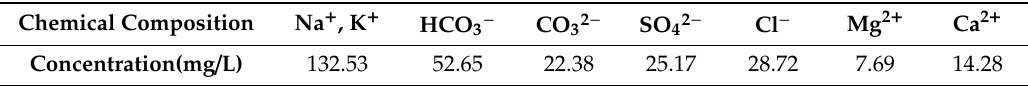
Table 1. Chemical composition of the experimental